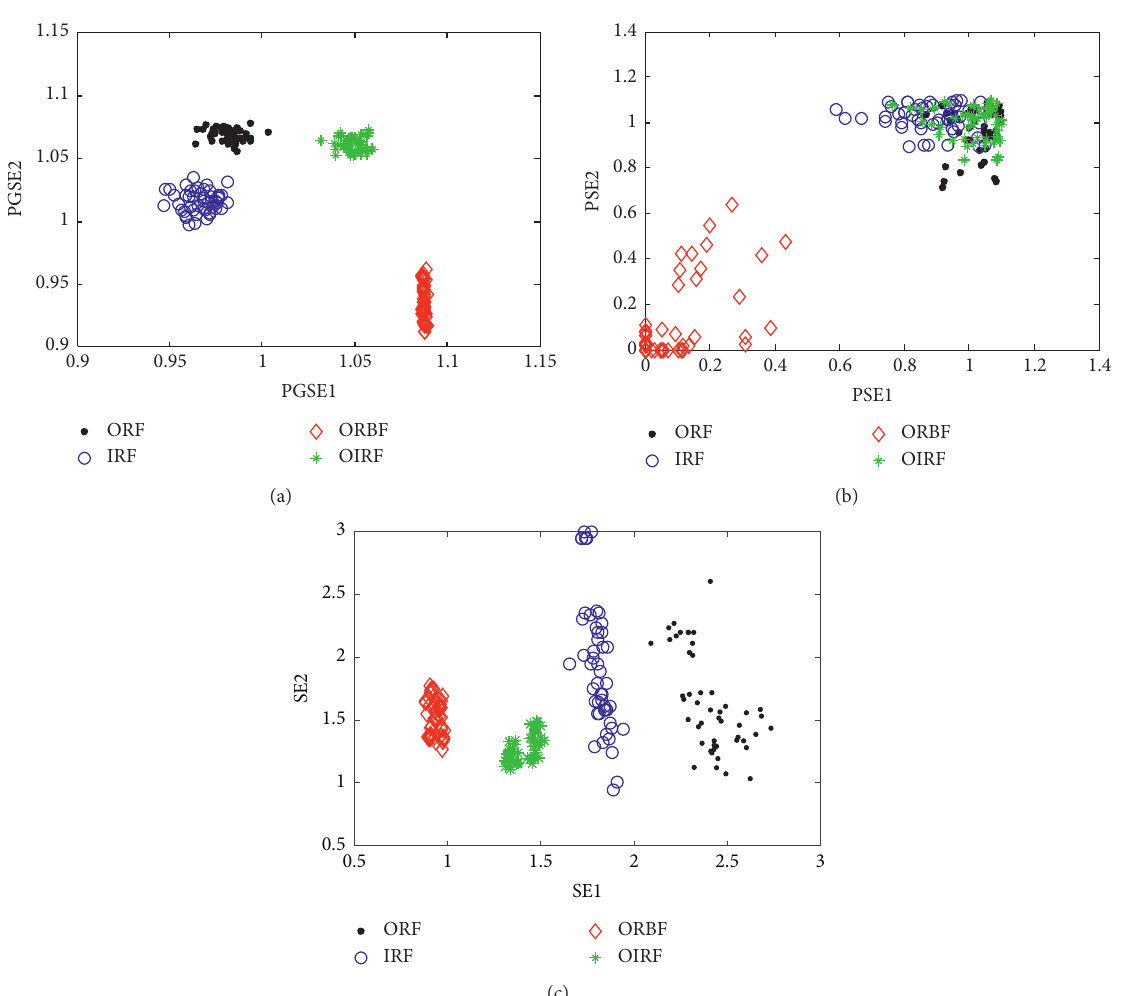
Figure 31: The plotting of the best two features selected by LS in case 2. (a) MPGSE and LS, (b) MPSE and LS, and (c) MSE and LS.